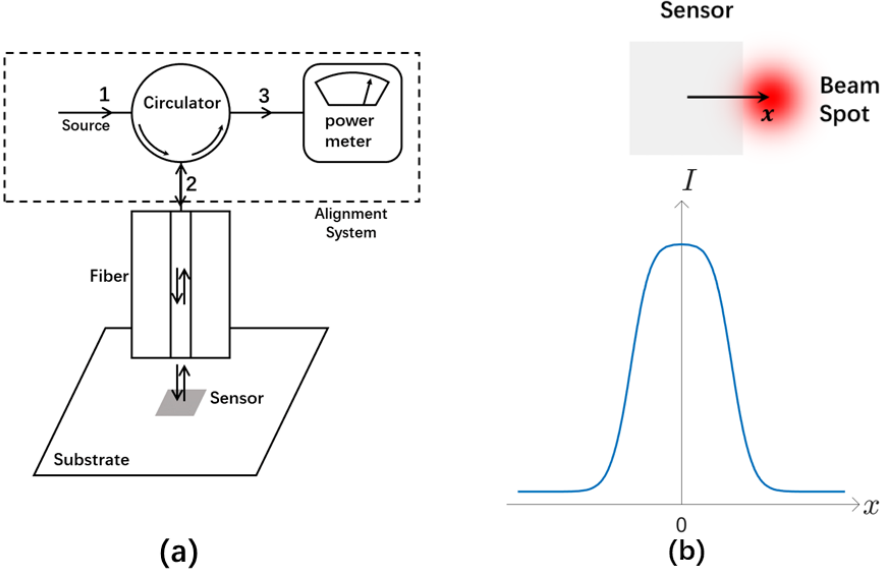
Figure 1. Alignment system and its working principle. ( a ) Alignment system based on the measure- ment of reflected wave intensity, with a single-mode fiber at the frequency of the signal wave used for alignment, a circulator in which light can only travel from port 1 to port 2, and from port 2 to port 3, and a power meter to measure the intensity of the reflected wave. ( b ) The jump in the intensity of the reflected wave when the beam spot of the fiber moves across the boundary between the sensor and the substrate, assuming the movement is along the midline between two opposite sides of a rectangular